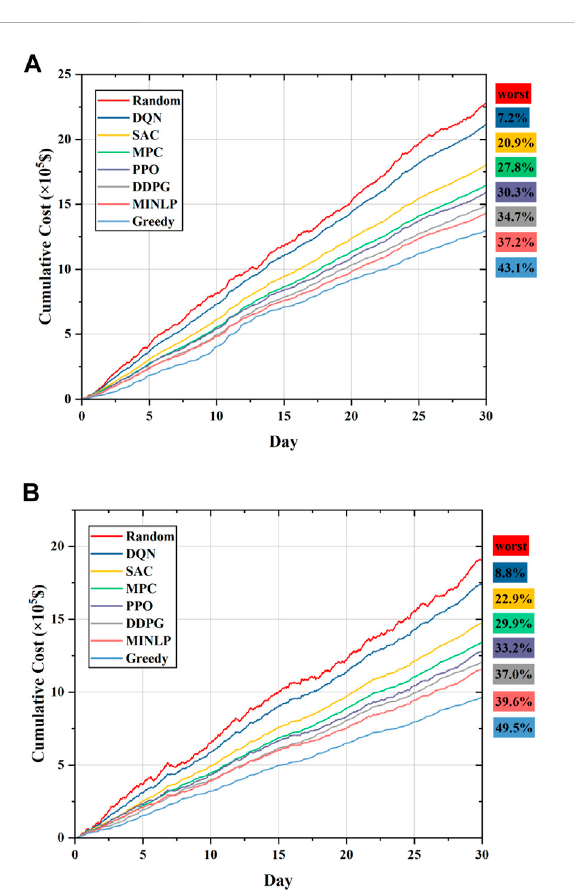
FIGURE 12 Cumulative daily operating cost over 30 consecutive days obtained bytheproposed approach andthecomparison methods: (A) Cumulativedaily operatingcost in thetestset for June; (B) cumulative daily operating cost in the test set for